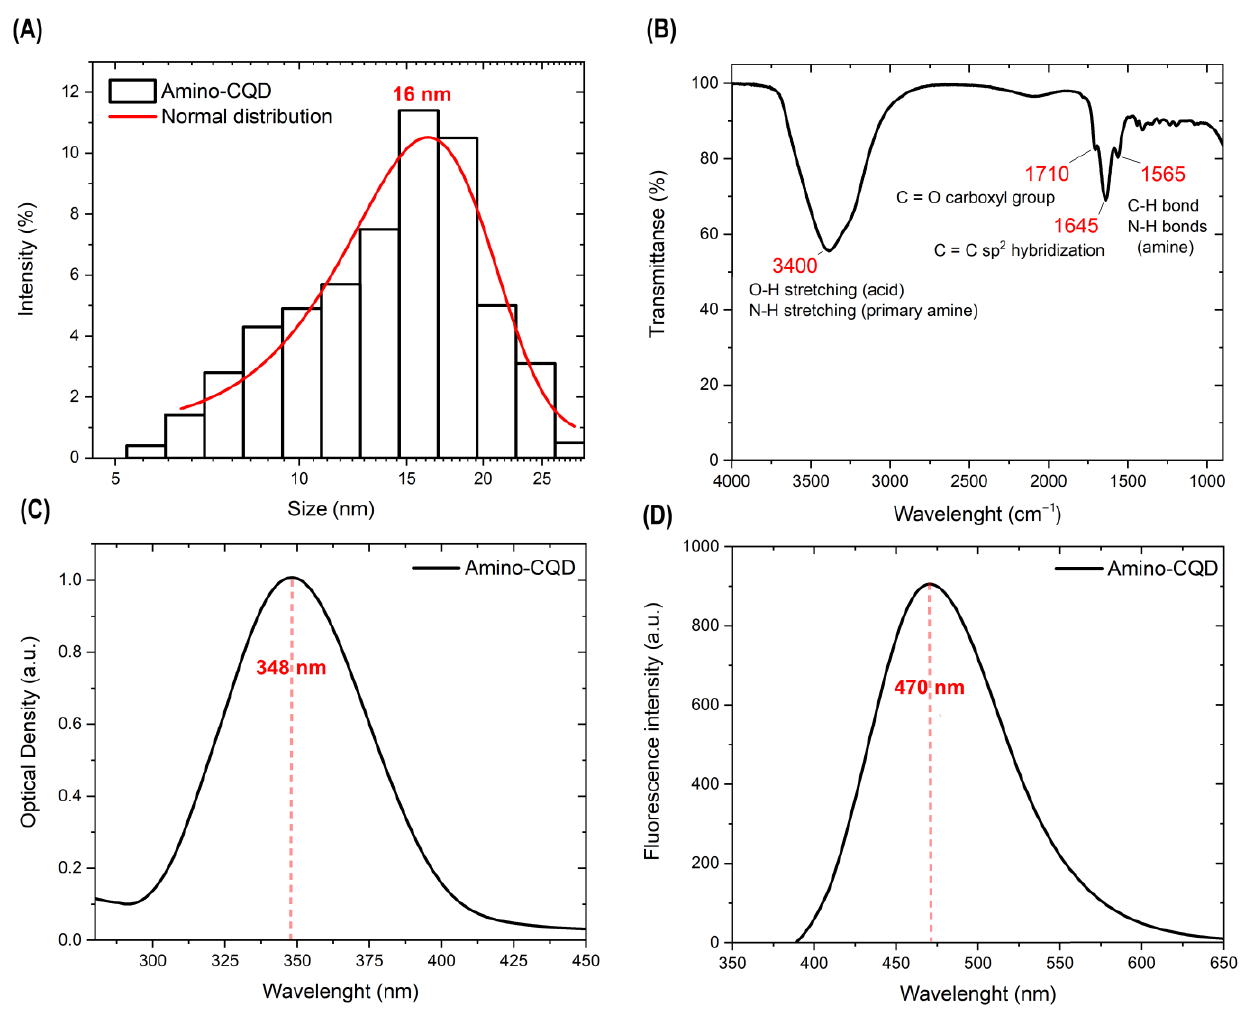
Figure 1. The primary characterization of Amino-CQD dispersion. ( A ) Size distribution, ( B ) IR spectra, ( C ) absorbance spectra and ( D ) emission spectra under 350 ex.